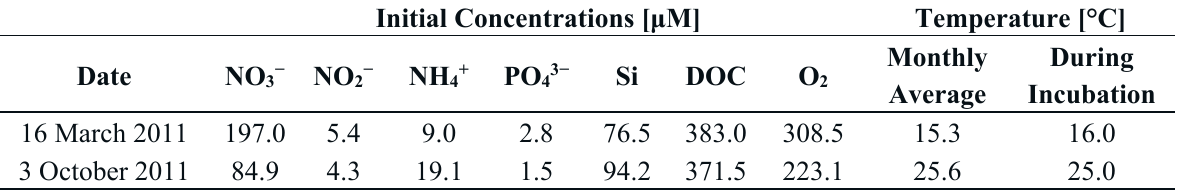
Table 1. Initial concentrations of dissolved nutrients and oxygen at the beginning of the incubation experiment, as well as monthly average ambient air temperature and air temperature during